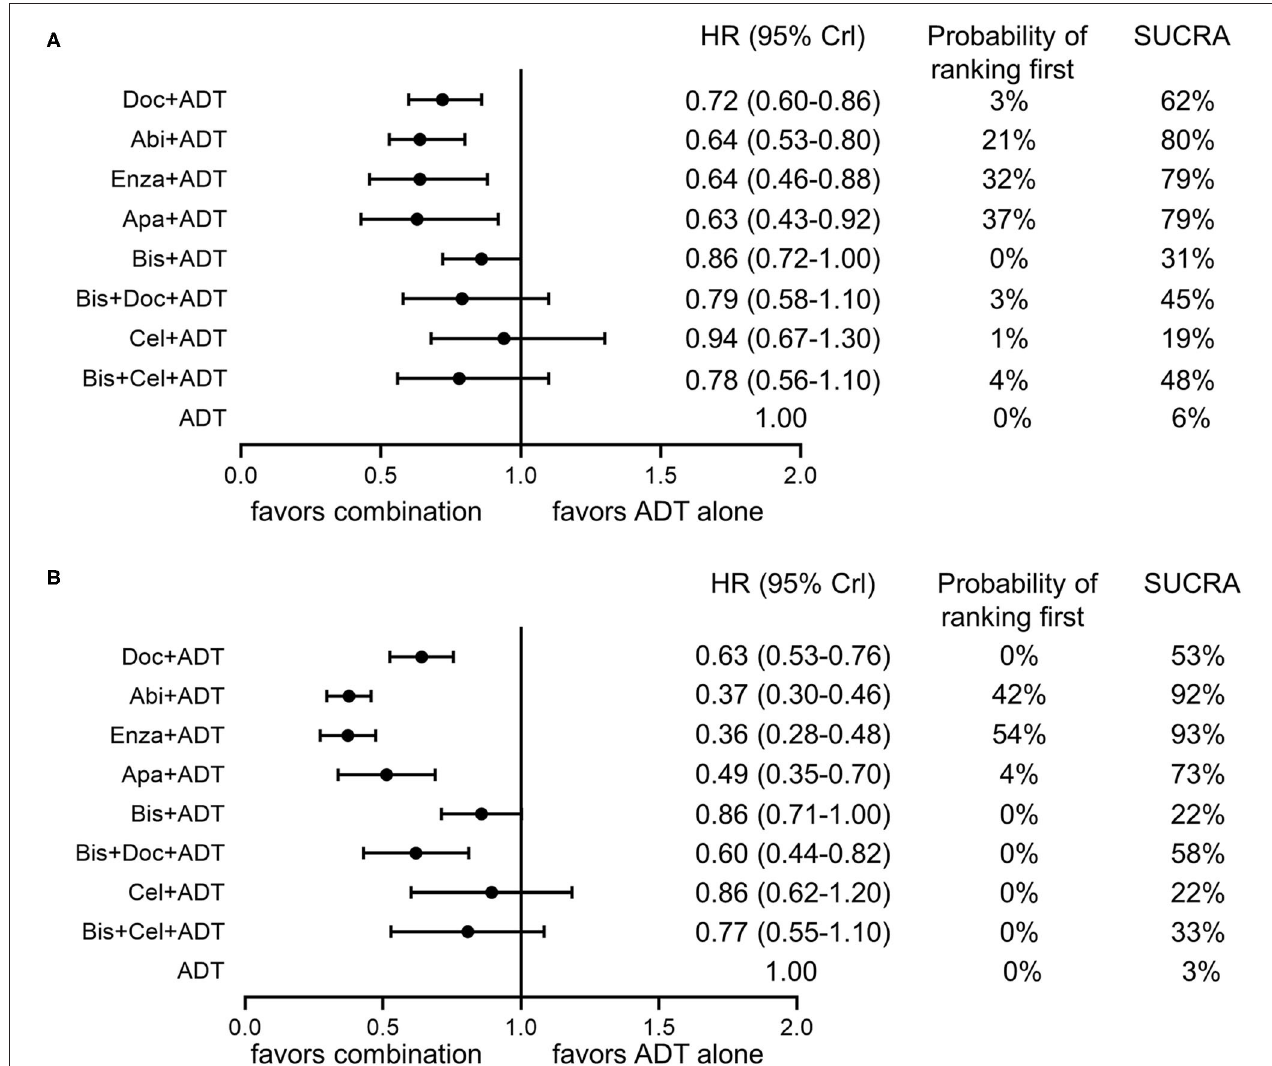
FIGURE 4 | Forest plots of network comparisons of effect of combination therapies compared to ADT alone on overall survival (A) and failure-free survival (B) . Rankings are presented as probabilities of ranking first and SUCRA. Doc, docetaxel; Abi, abiraterone; Enza, enzalutamide; Apa, apalutamide; ADT, androgen-deprivation